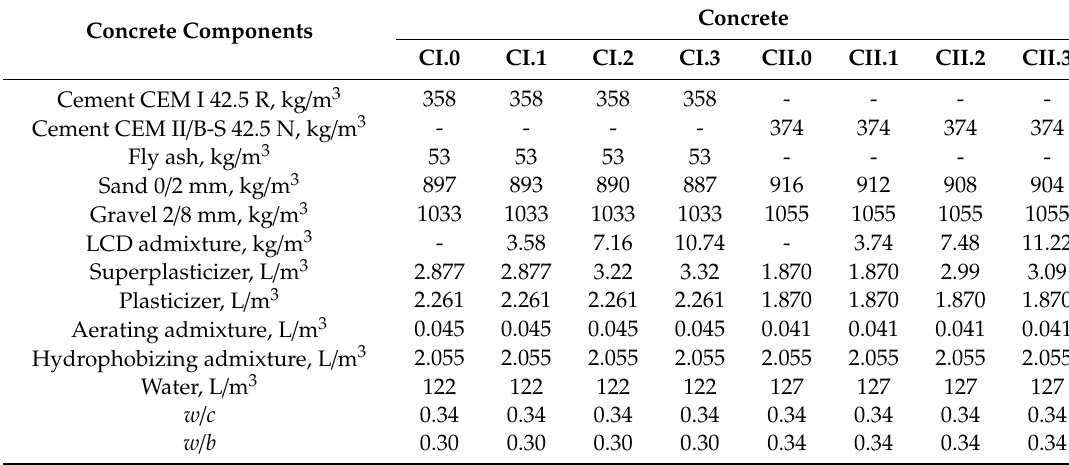
Table 6. Composition of concrete